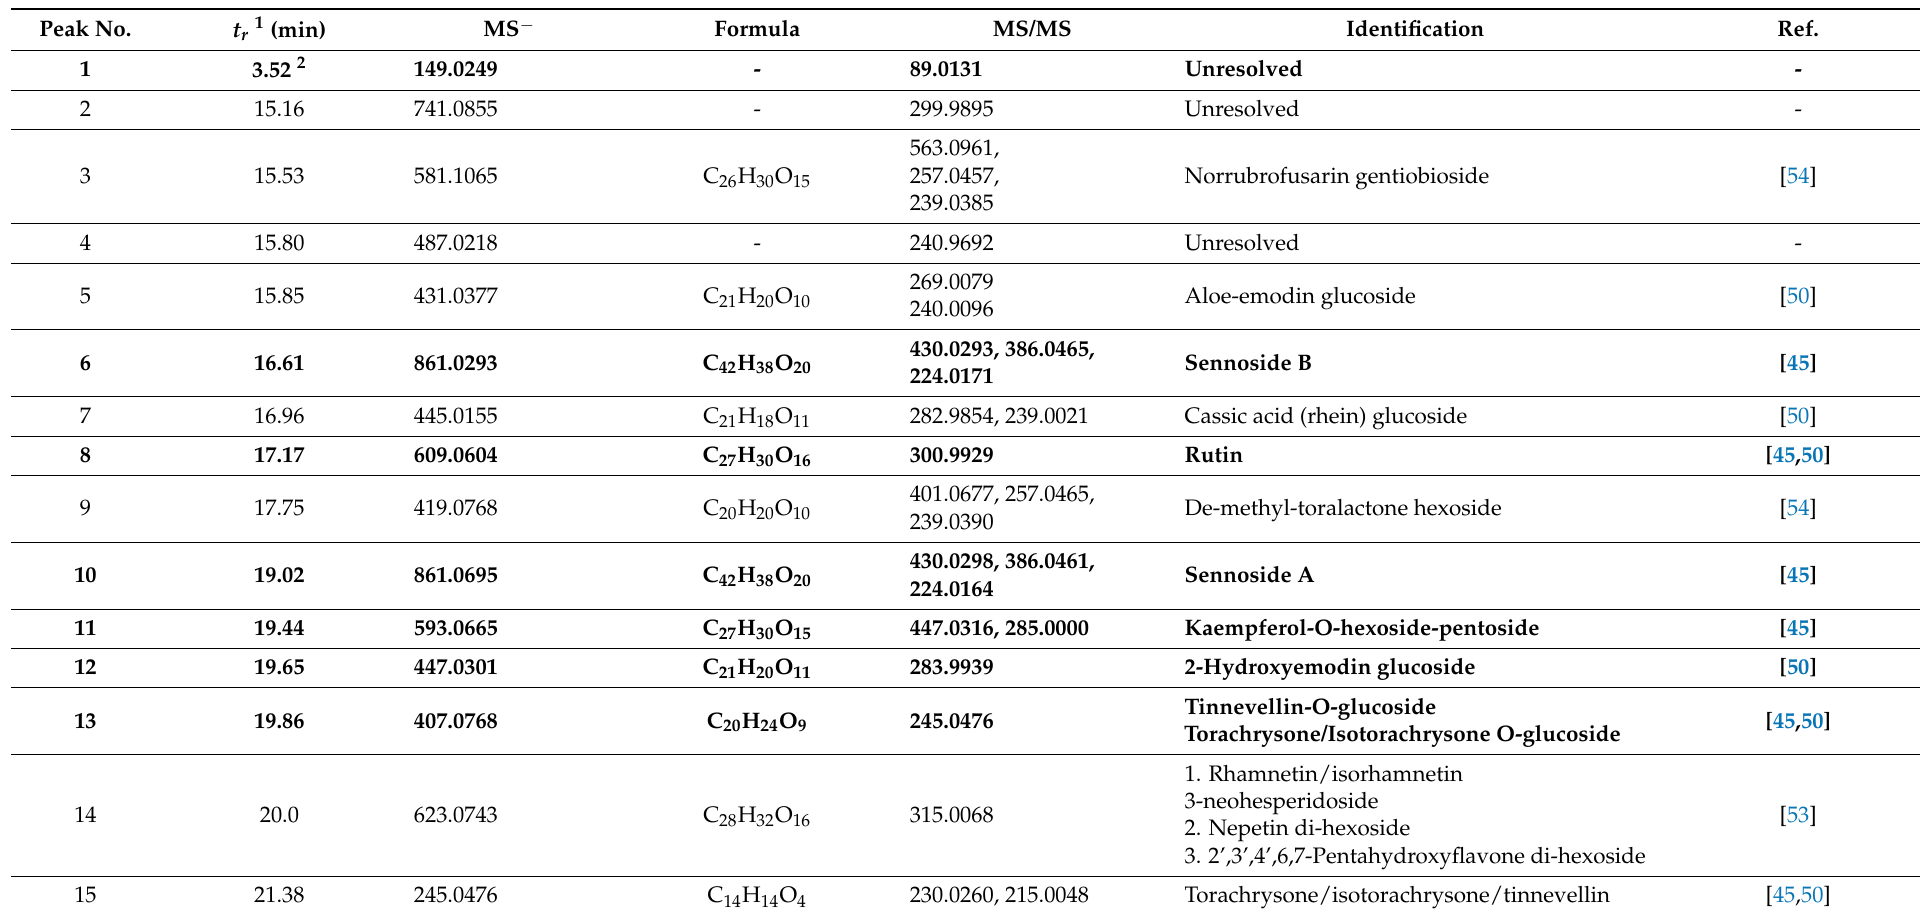
Table 4. Identification of the compounds in the chromatograms of Senna italica (peak number in Figure 7, retention time in the chromatogram, m / z of [M–H] − ion, molecular formula, identity, and reference to mass spectrum used for confirmation of the substance). Peak